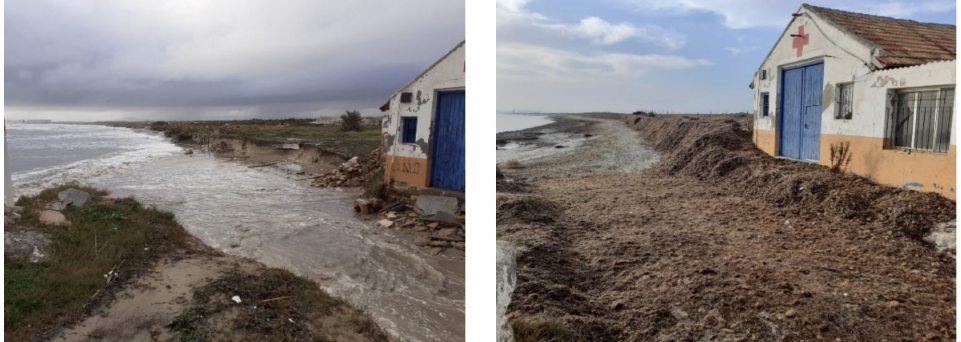
Figure 6. Recovery of La Llana beach after the creation of a Posidonia barrier (Source: LIFE- SALINAS